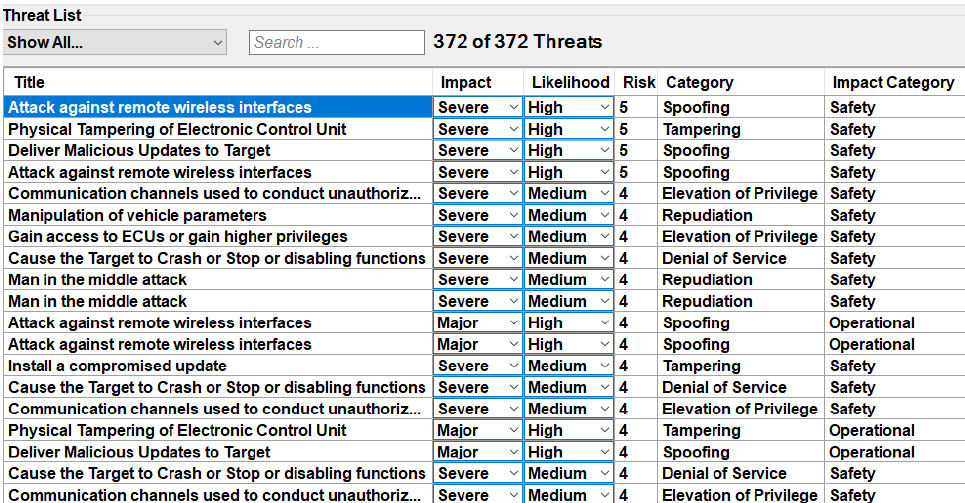
Figure 14. Automatically assessed threats based on the system architecture.